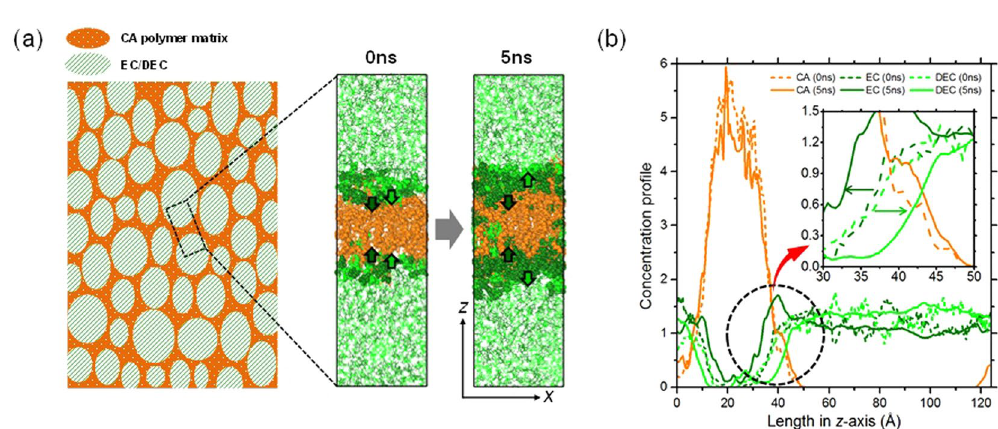
Figure 6. ( a ) Schematic diagrams of cross-section of CA polymer matrix with EC/DEC liquid mixture. The vol% ratio of CA to EC/DEC is 20:80, where that of EC to DEC is 50:50. Snapshots of MD simulations, which are presented on the left, show the initial (0 ns) and final (5 ns) states of the system. Dark green and light green arrows indicate the diffusion of EC and DEC molecules, respectively. ( b ) Concentration profiles of CA, EC, and DEC of the initial (0 ns) and final (5 ns) states of the layered system. Orange, dark green and light green colors represent CA, EC, and DEC molecules,